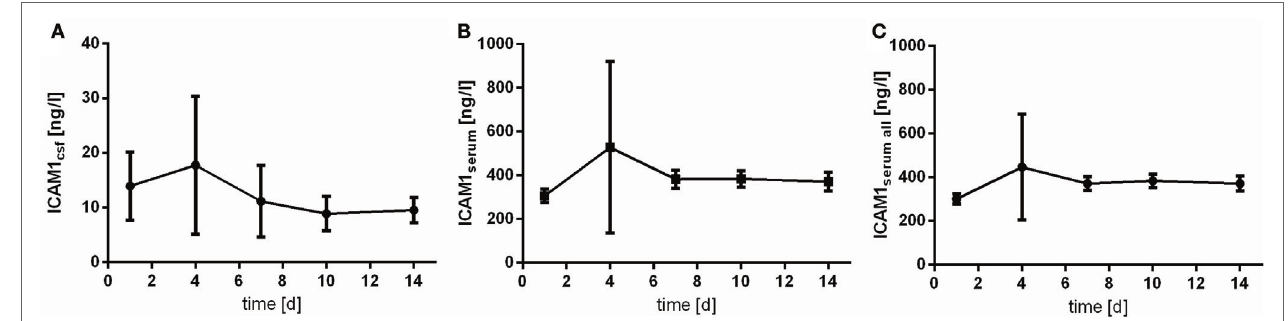
FigUre 3 | Time courses of intercellular adhesion molecule 1 (ICAM1) in cerebrospinal fluid (CSF) samples [ (a) ; ICAM1csf], serum samples of the patients with CSF samples [ (B) ; ICAM1serum], and all serum samples available [ (c) ; ICAM1serum all] and their 95% confidence interval are displayed. Differences between nadir and